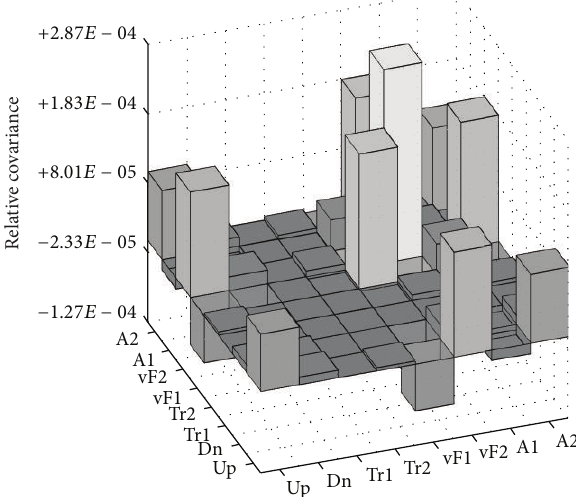
Figure 27: Homogenized property covariance due to 𝜎 U 235 𝛾 covari- ance using FCWG.